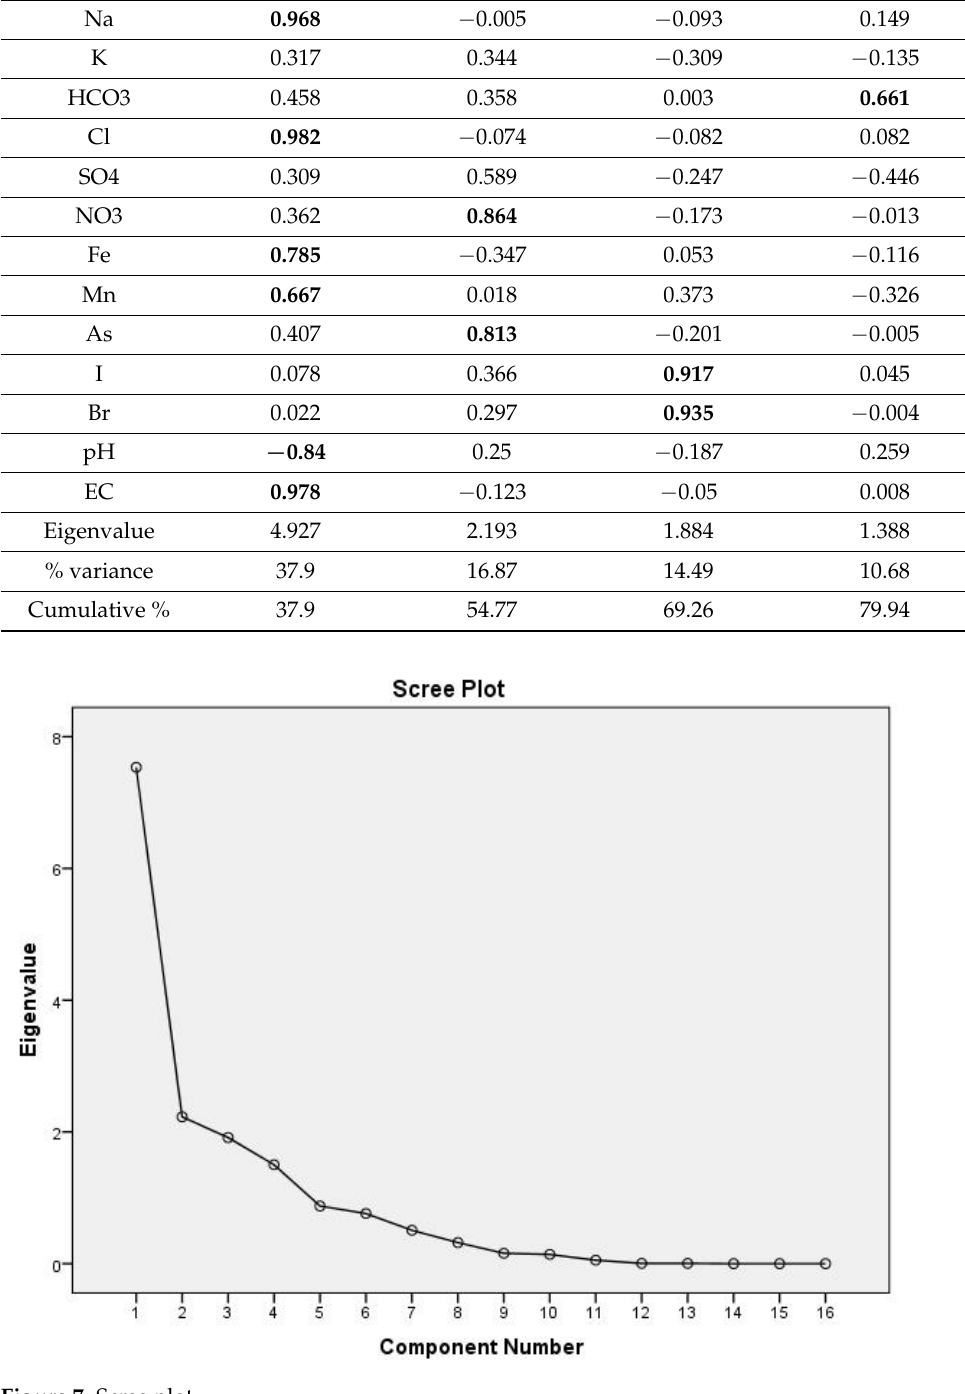
Figure 7. Scree Figure 7. Scree plot.